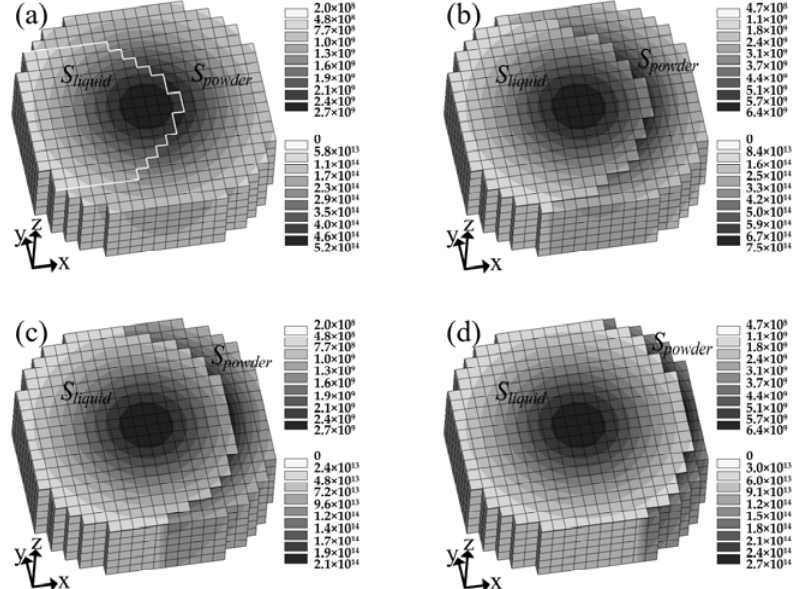
Figure 11. Area distribution of each state and their absorbed energy density distribution under the laser spot at different laser power and scanning velocity: ( a ) P = 90 W, V = 1.25 m/s; ( b ) P = 210 W, V = 1.25 m/s; ( c ) P = 90 W, V = 0.25 m/s; ( d ) P = 210 W, V = 0.25 m/s.